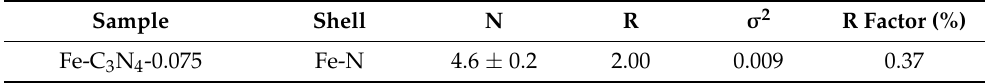
Table 1. Fitting results of Fe-C 3 N 4 -0.075 EXAFS.